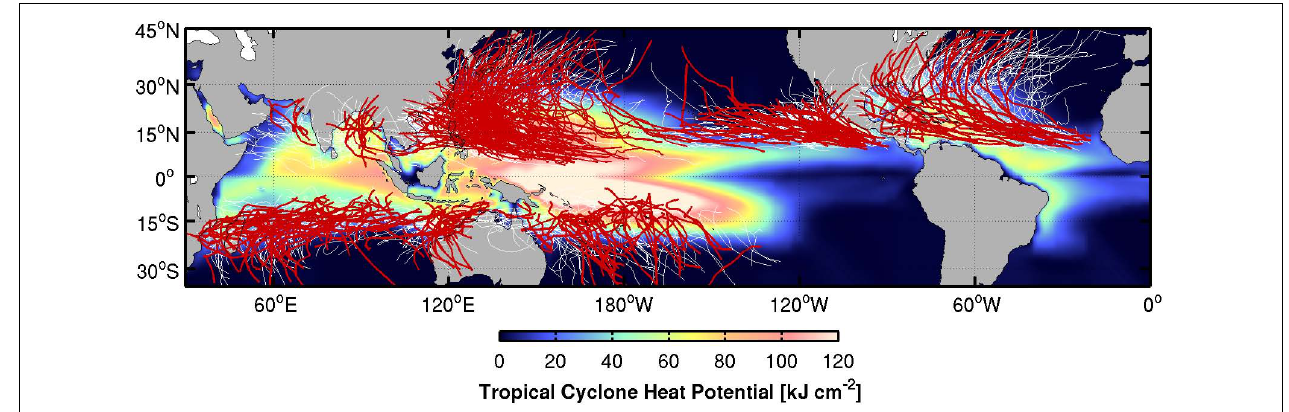
FIGURE 1 | Global TC tracks during the time period of 1993–2011, overlaid on the average hurricane season satellite-derived tropical cyclone heat potential (TCHP) (upper-ocean heat content (OHC) above 26 ◦ C isotherm) for each hemisphere computed for the same time period. Thin white lines show the tracks of TCs with Cat-2 and below according to the Saffir–Simpson TC wind scale, and red lines show tracks of major TCs with Cat-3 and